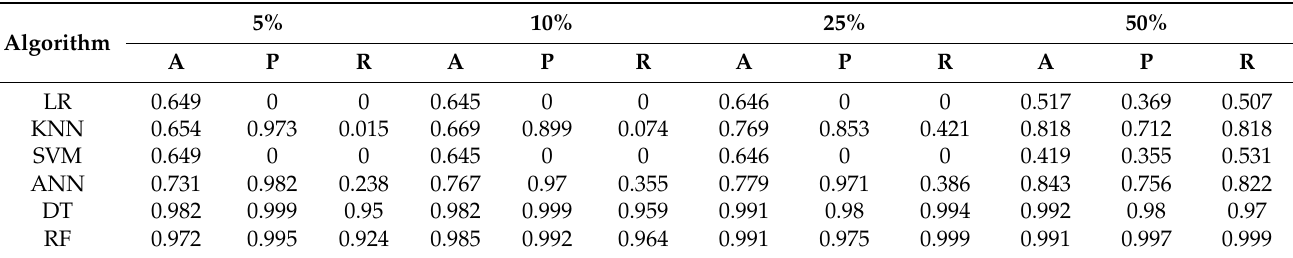
Table 4. Metrics vs. percentage of the faults in the learning set.